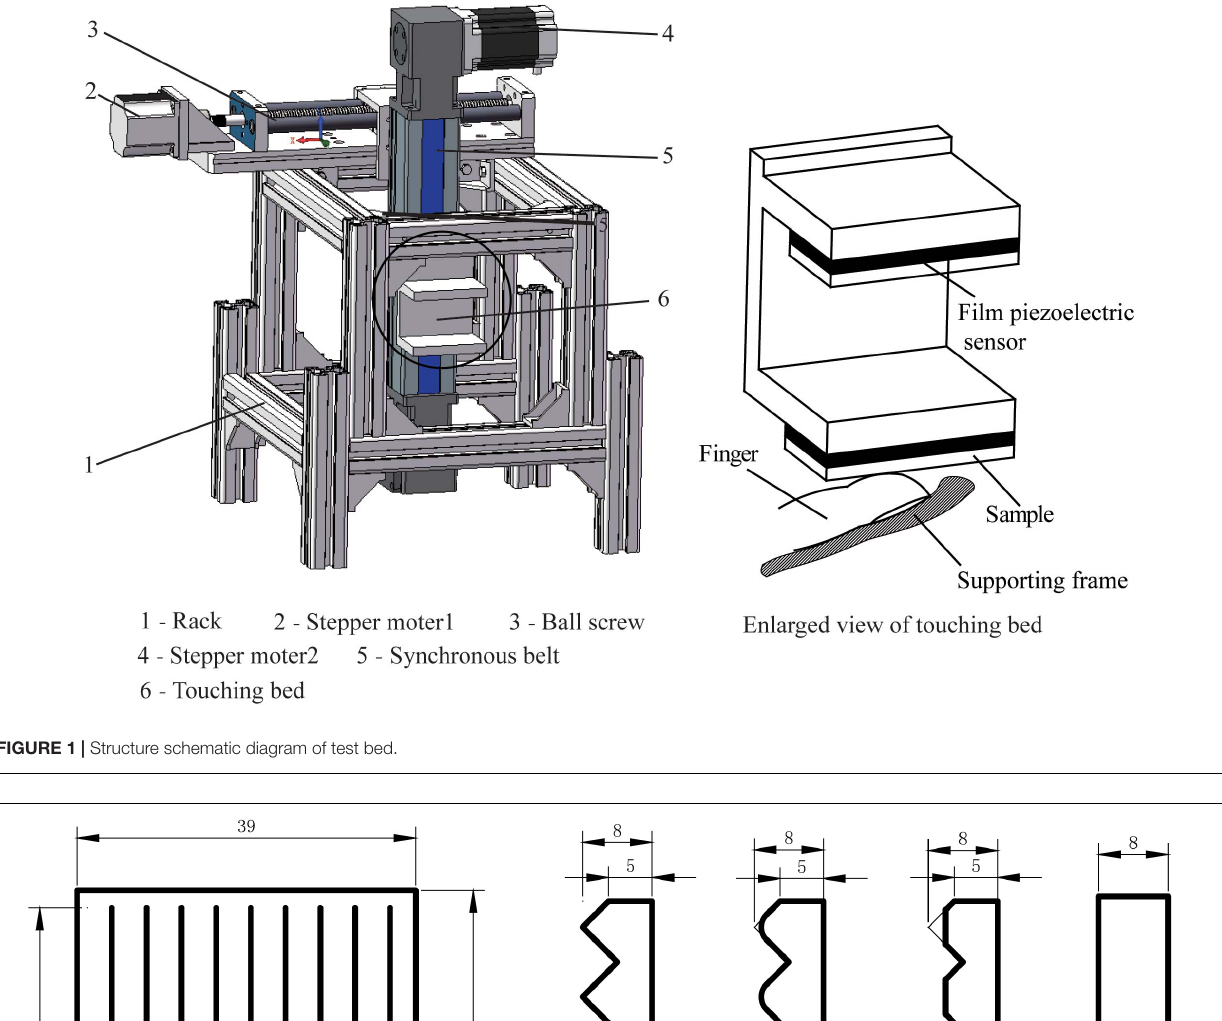
FIGURE 1 | Structure schematic diagram of test bed.